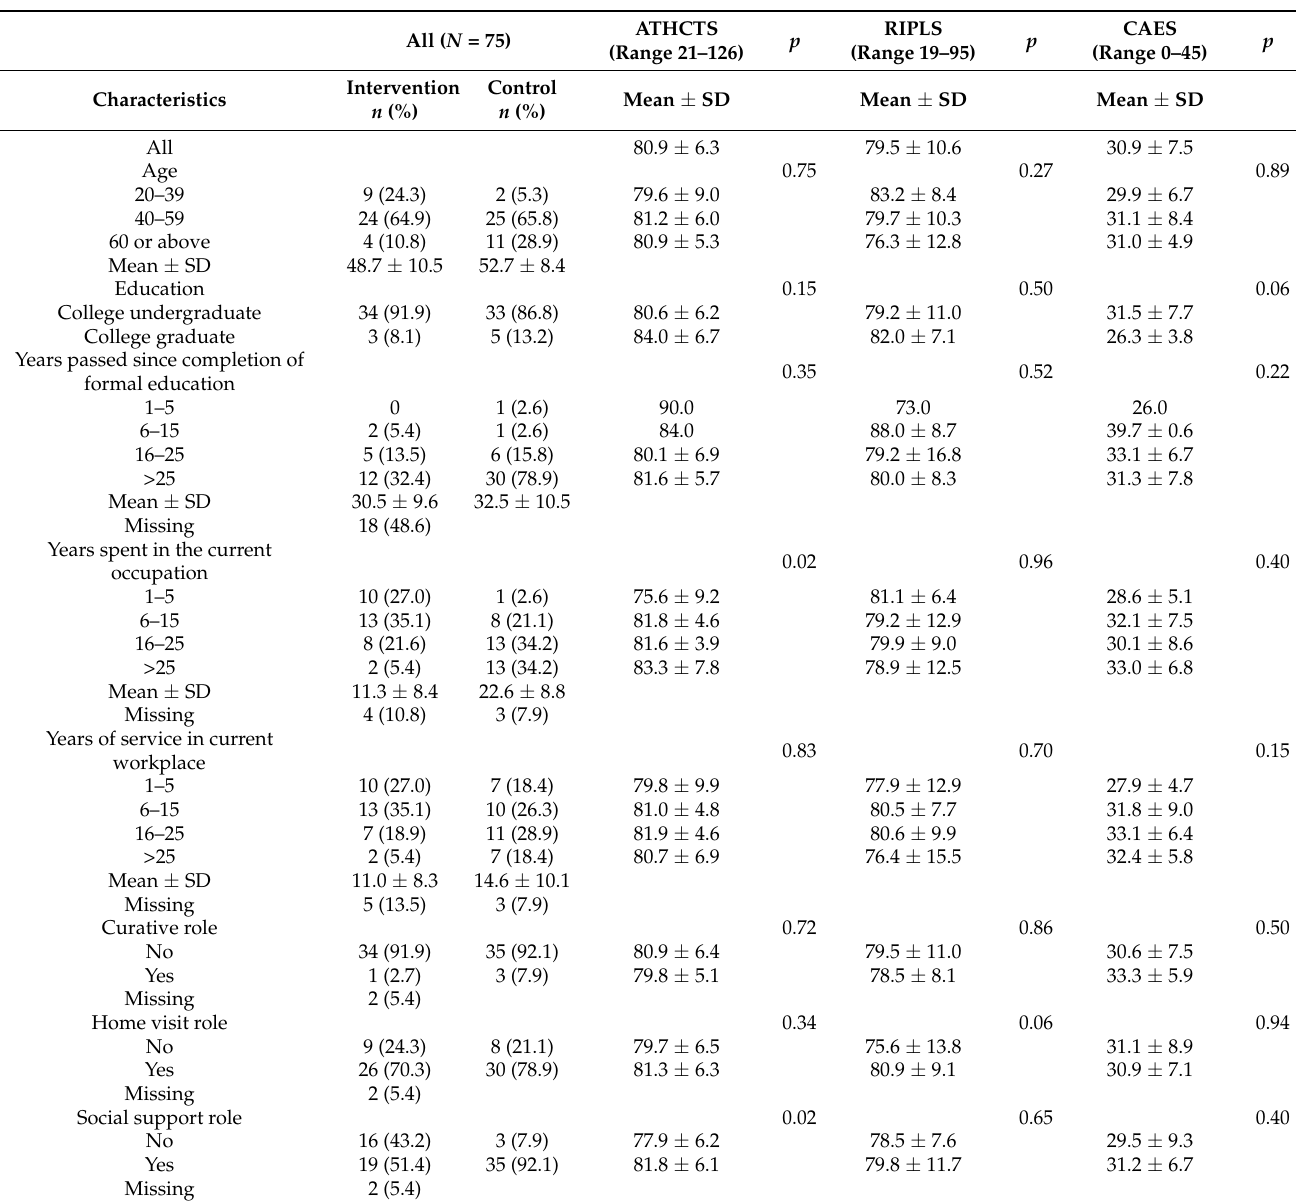
Table 1. ATHCTS, RIPLS, and CAES scores of community health workers at baseline ( N = 75).